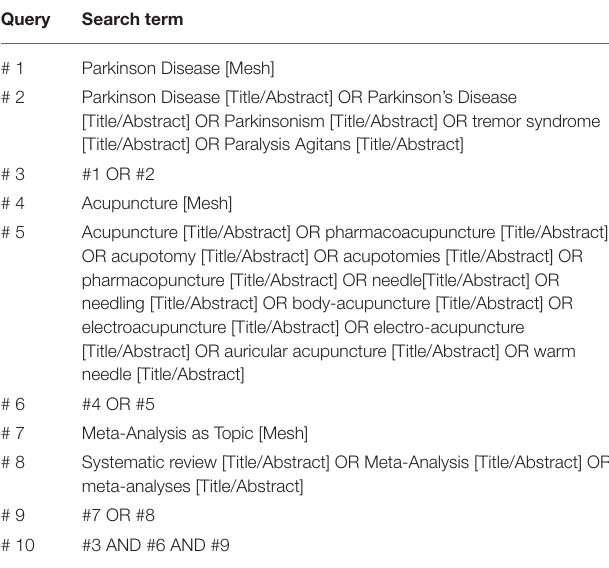
TABLE 1 | Search strategy for the PubMed